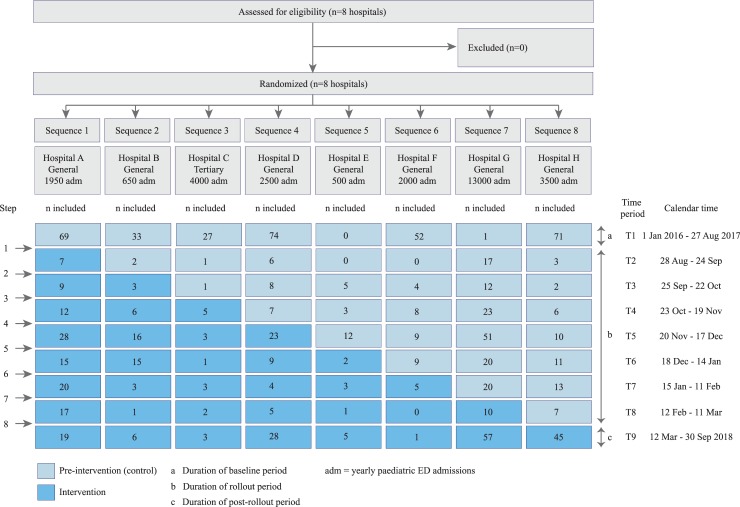
Design of the trial.ED, emergency department.